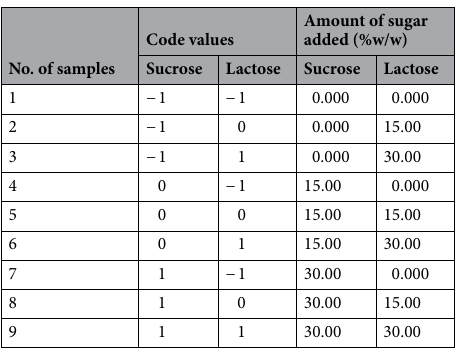
Table 2. The CCD structure for generating the training